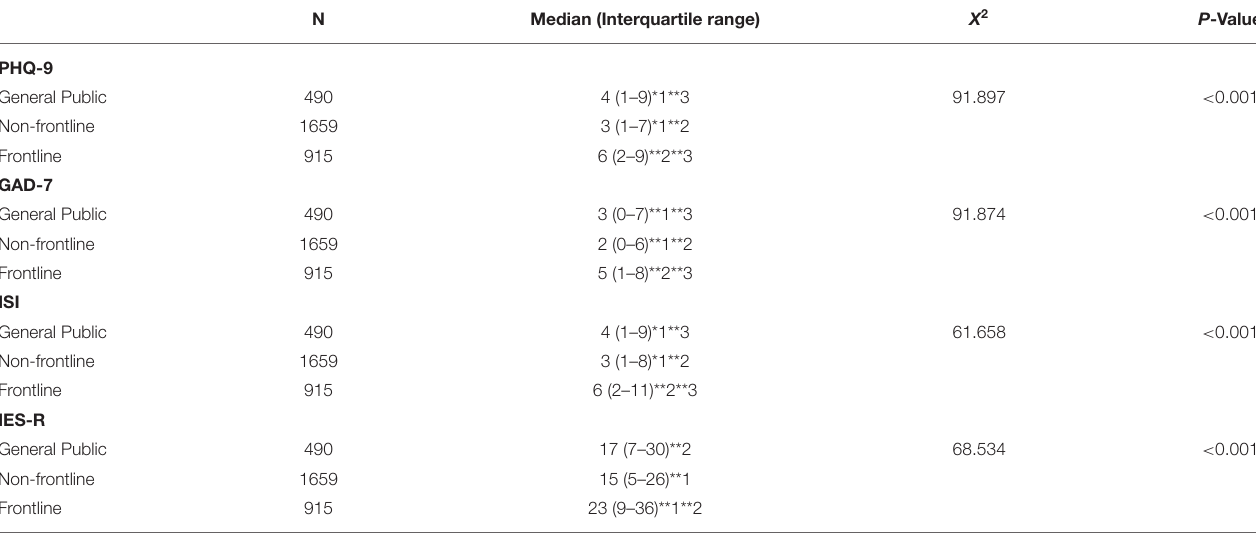
TABLE 2 | Characteristics of mental health status of participants (general public, frontline, and non-frontline) ( N = 3,064). N Median (Interquartile